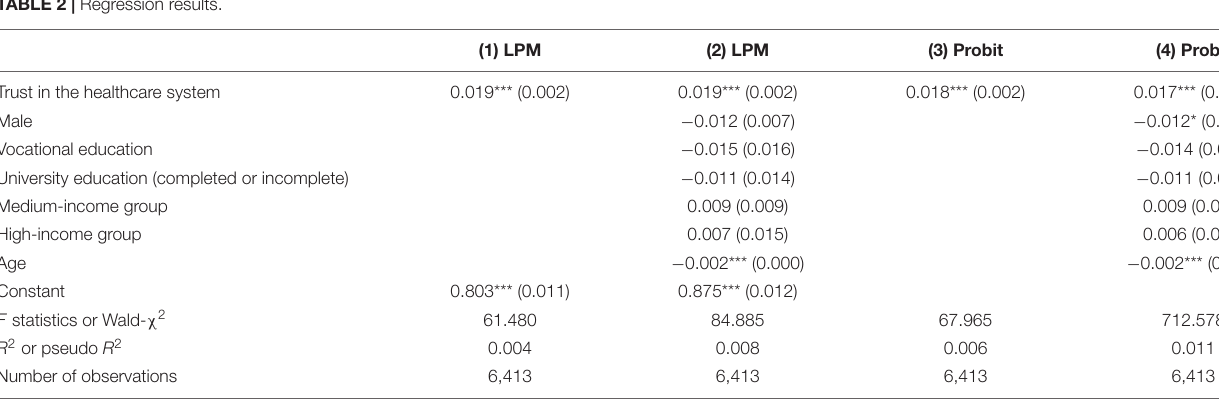
TABLE 2 | Regression